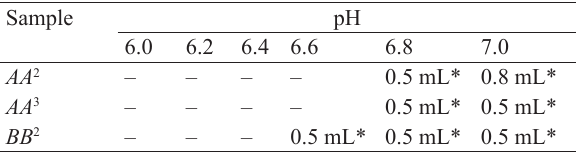
Table 6 Thermal stability of reconstituted dried milk from cows with different CSN3 genotypes by calcium chloride test Sample рН